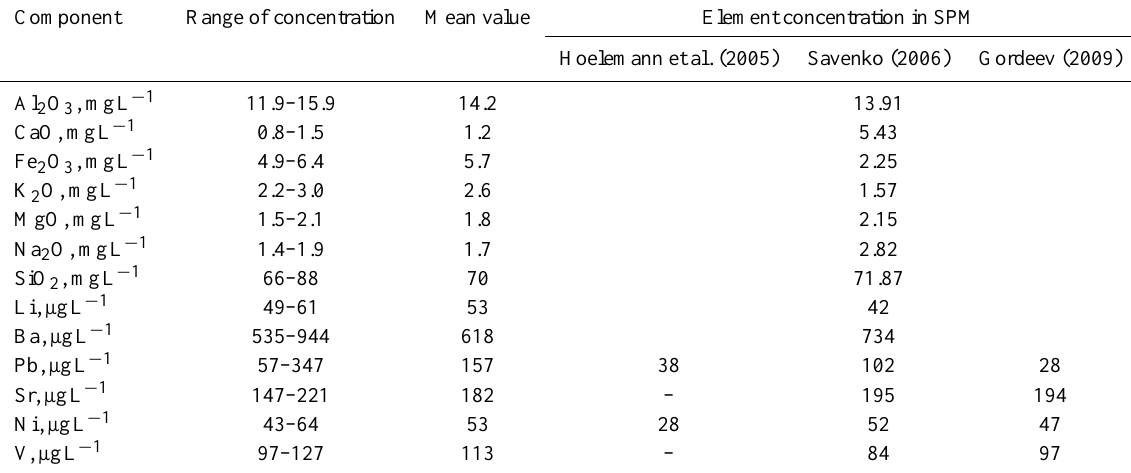
Table 5. Chemical elements found in suspended material from the Lena River delta in 2002–2012 in comparison with data from Savenko (2006), Hoelemann et al. (2005), and Gordeev (2009). Component Range of concentration Mean value Element concentration in